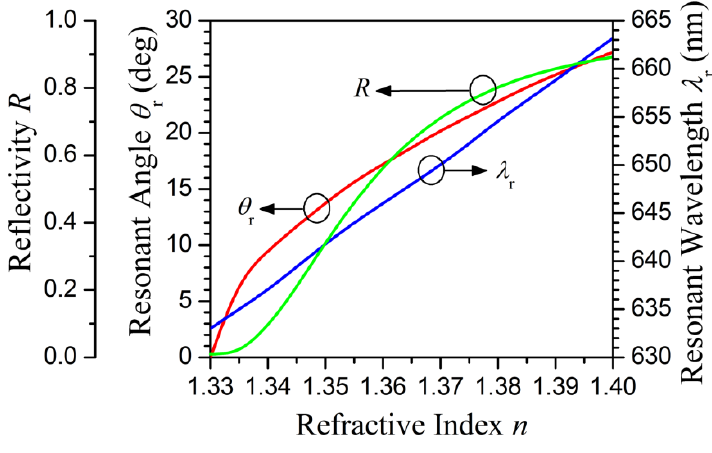
Figure 4. The resonant wavelength ( ) for the normal incident light, the resonant angle ( θ ) for the oblique incident light at 632.8 nm, and the reflectivity ( R ) for the normal r incident light at 632.8 nm as functions of the refractive index of the